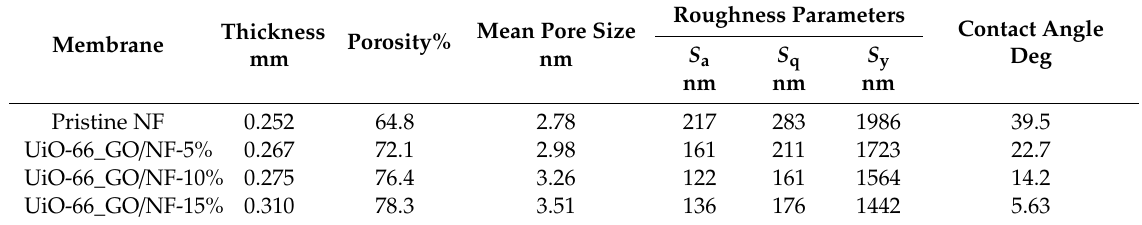
Table 1. Characterization of the pristine and composite